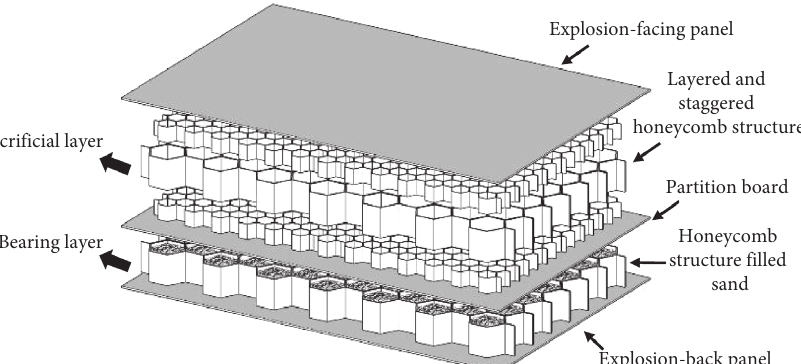
Figure 2: Schematic diagram of biomimetic layered honeycomb structure.